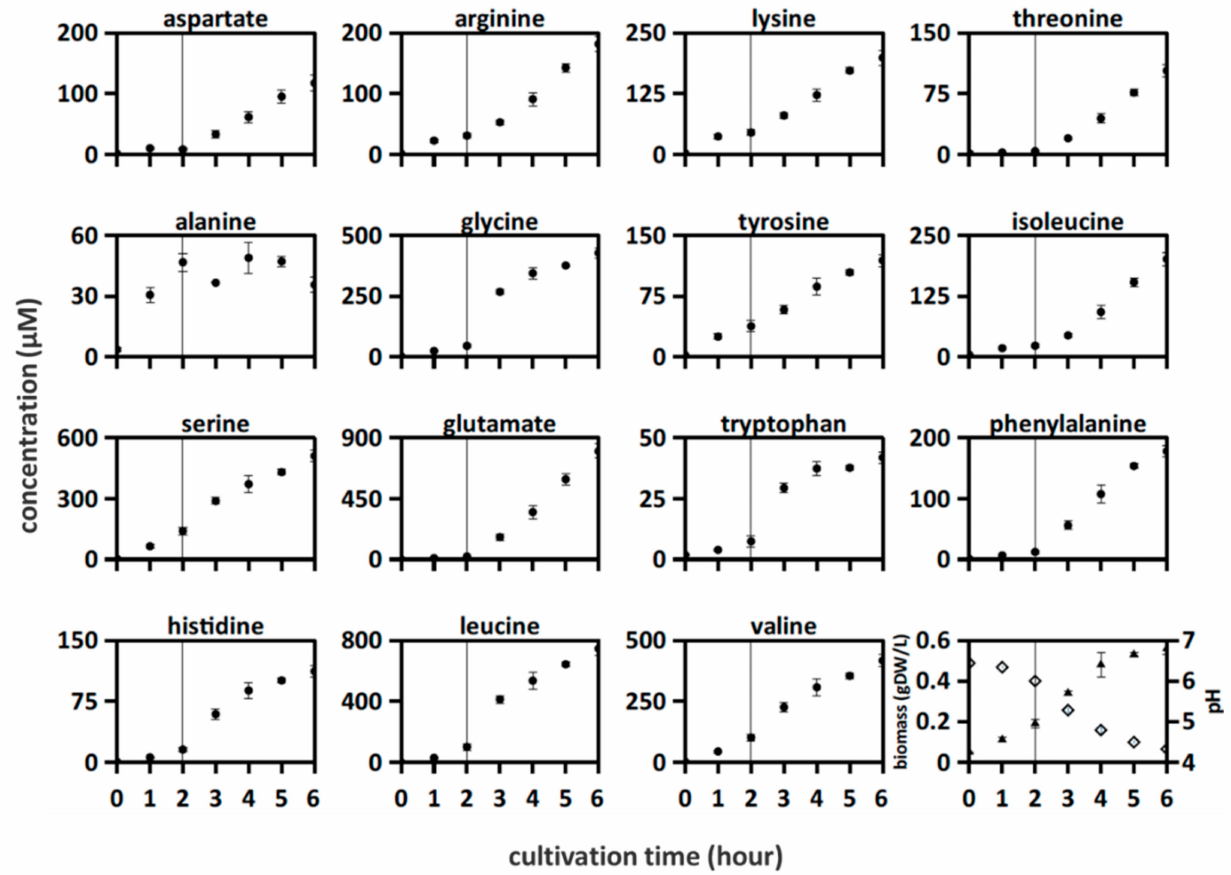
Figure 1. Amino acid concentrations were measured in Lactobacillus bulgaricus LB.1 culture in synthetic medium supplemented with casein (SMcas). The line indicates a change in increasing amino acid concentration profiles after 2 h. Downright: biomass (triangle) and pH (rhomb)